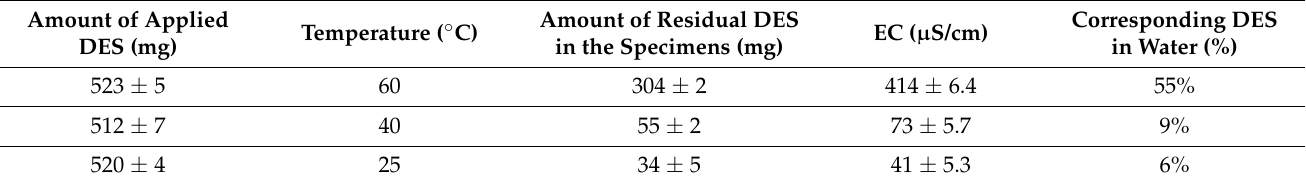
Table 4. Results obtained from electrical conductivity measurements (EC) on laboratory samples treated with